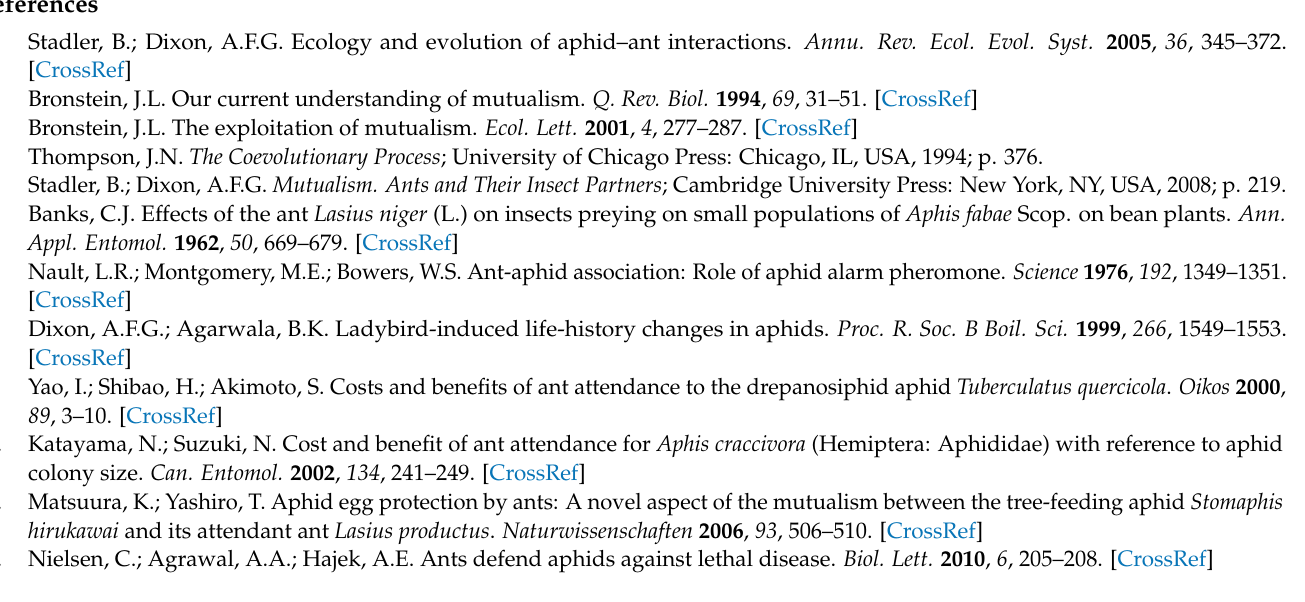
Table S2: Mean values of measured structures; Table S3: Mean ratios of measured